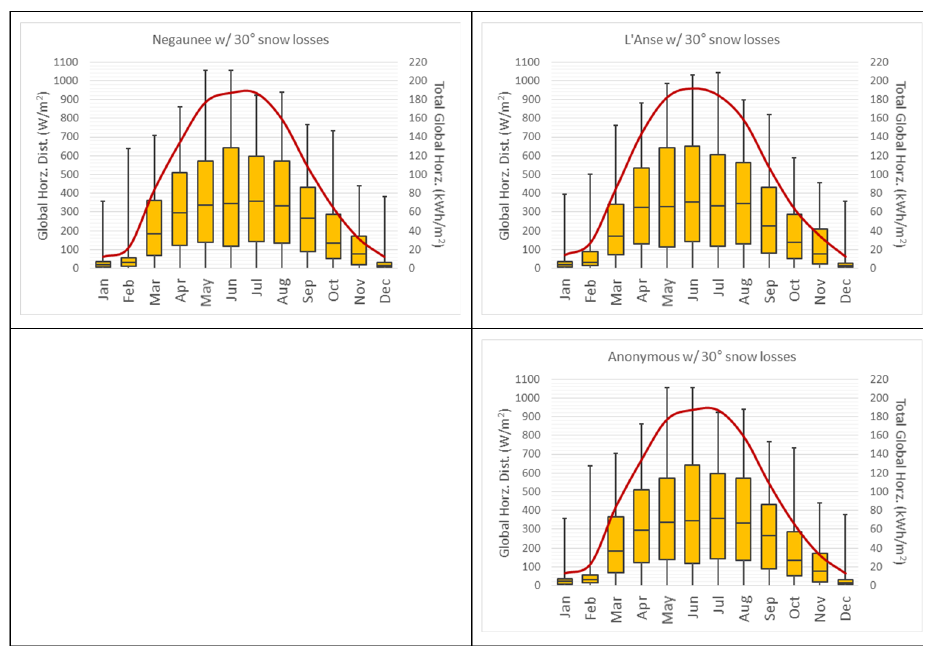
Figure A1. Monthly GHI distributions and totals with snow losses at a 30 tilt.